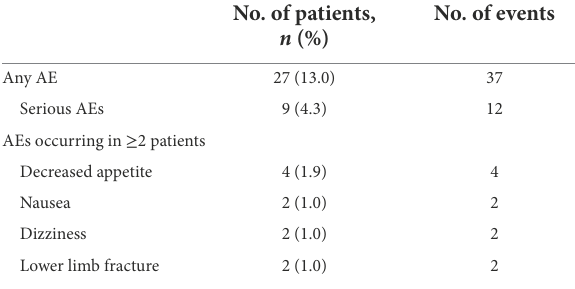
TABLE 3 Summary of AEs (safety analysis set; N = 207).